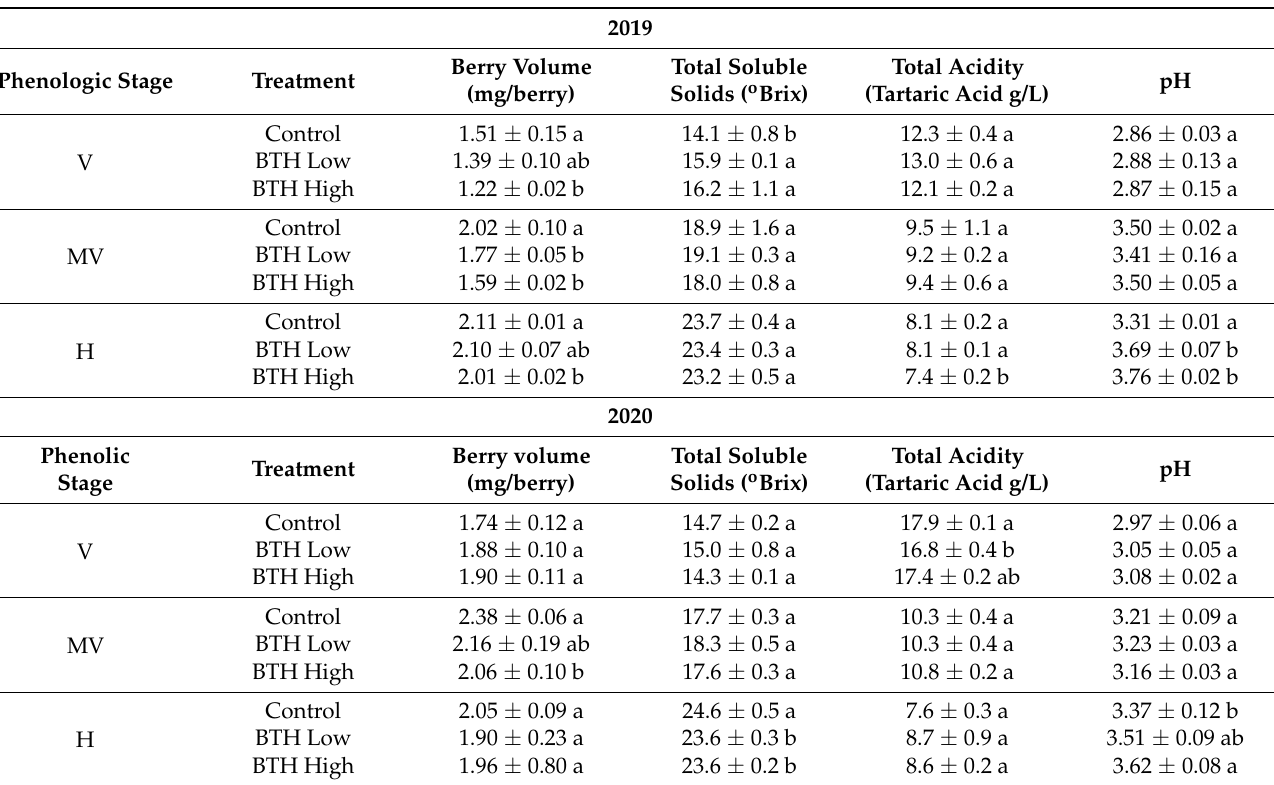
Table 5. Physiochemical characteristics of Mouhtaro grapes at three phenological